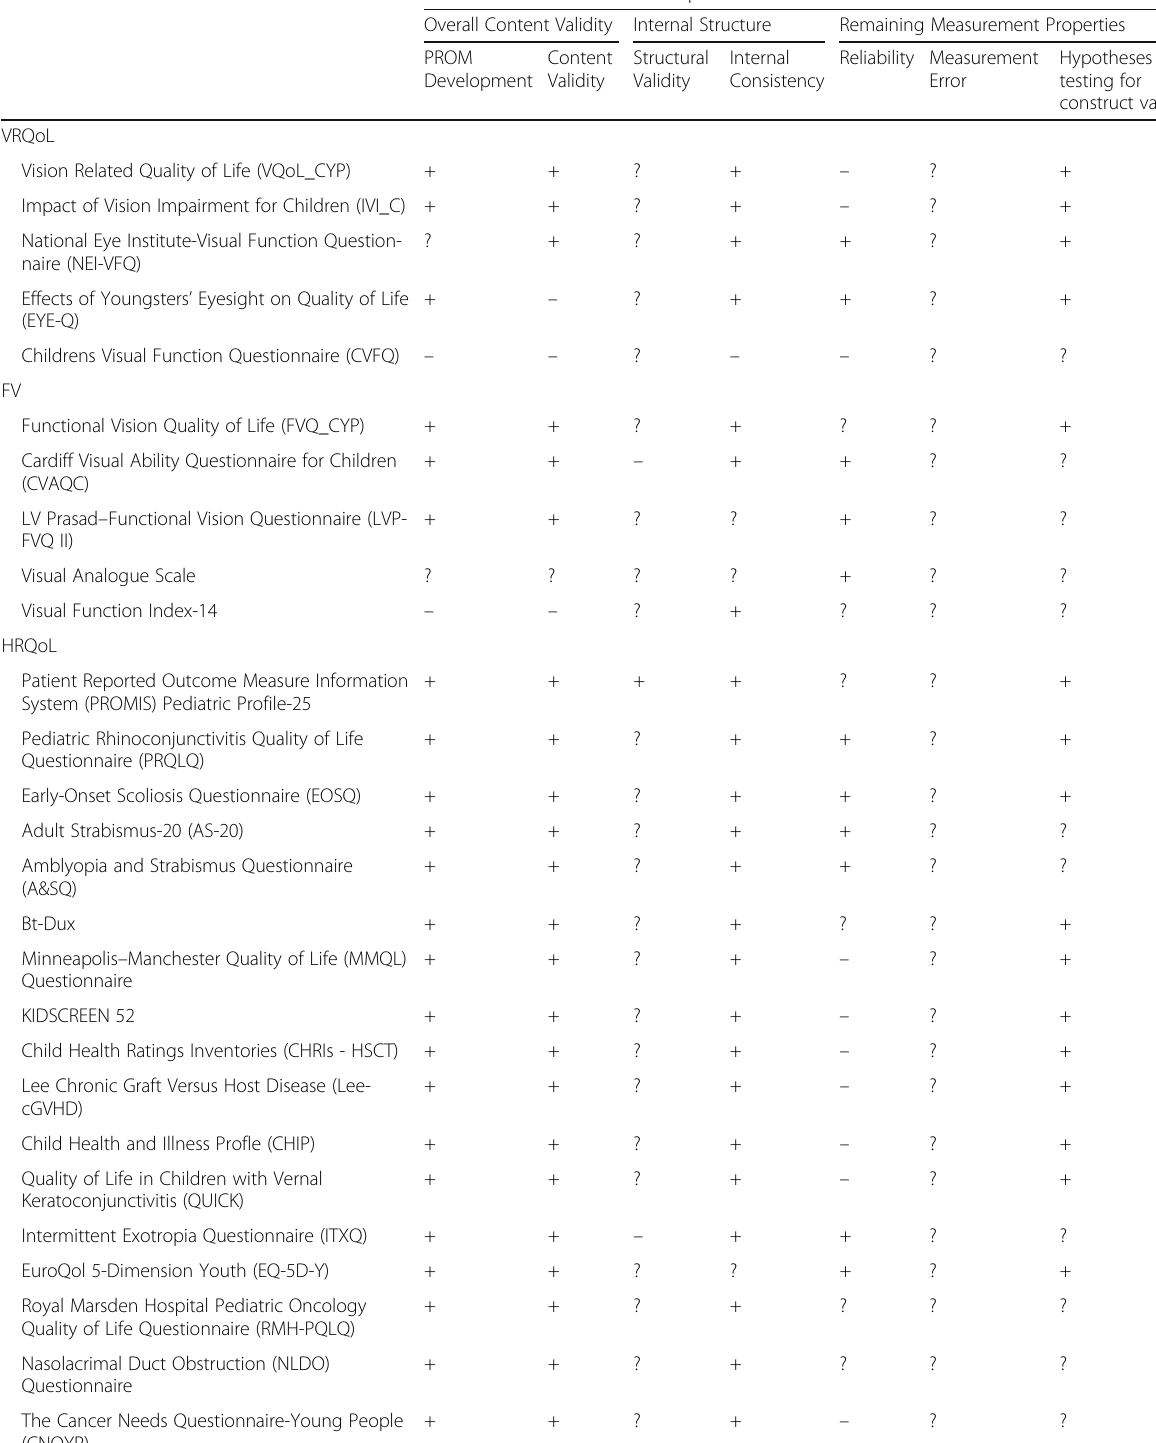
Table 1 Quality analysis of all identified PROMs ( n = 100). The COSMIN ‘ good property checklist ’ was applied on 100 PROMs, across 7 measurement properties stratified by construct. PROMs were ranked highest score of sufficient quality to lowest, within a construct. ‘ + ’ indicates a score of sufficient quality, ‘ ? ’ indicates that the specific measurement property was not reported on, and ‘ - ’